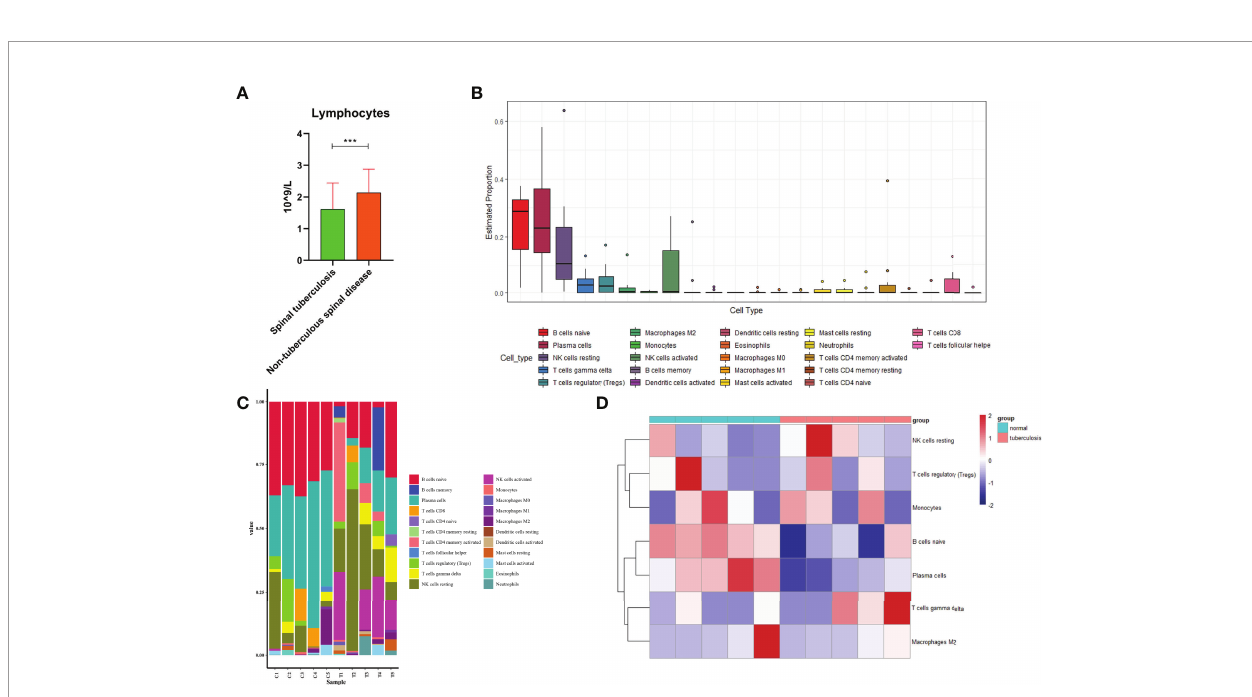
FIGURE 5 | Immune cells analysis. (A) Comparison of lymphocytes in spinal tuberculosis and nontuberculous spinal disease. (B) The estimated distribution of 22 immune cells was plotted. (C) The expression ratio of 22 immune cells in each sample was plotted. (D) Heatmap showed expression of immune cells in spinal tuberculosis and non-spinal tuberculosis tissues and showed that the expression of B cells naive former tissues was lower than that in the latter tissues.